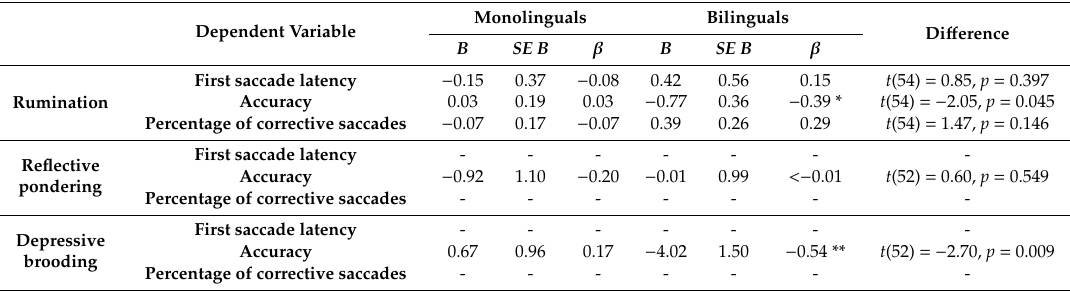
Table 5. Regression coe ffi cients and t-statistics of the relationship between rumination, reflective pondering, and depressive brooding and the dependent